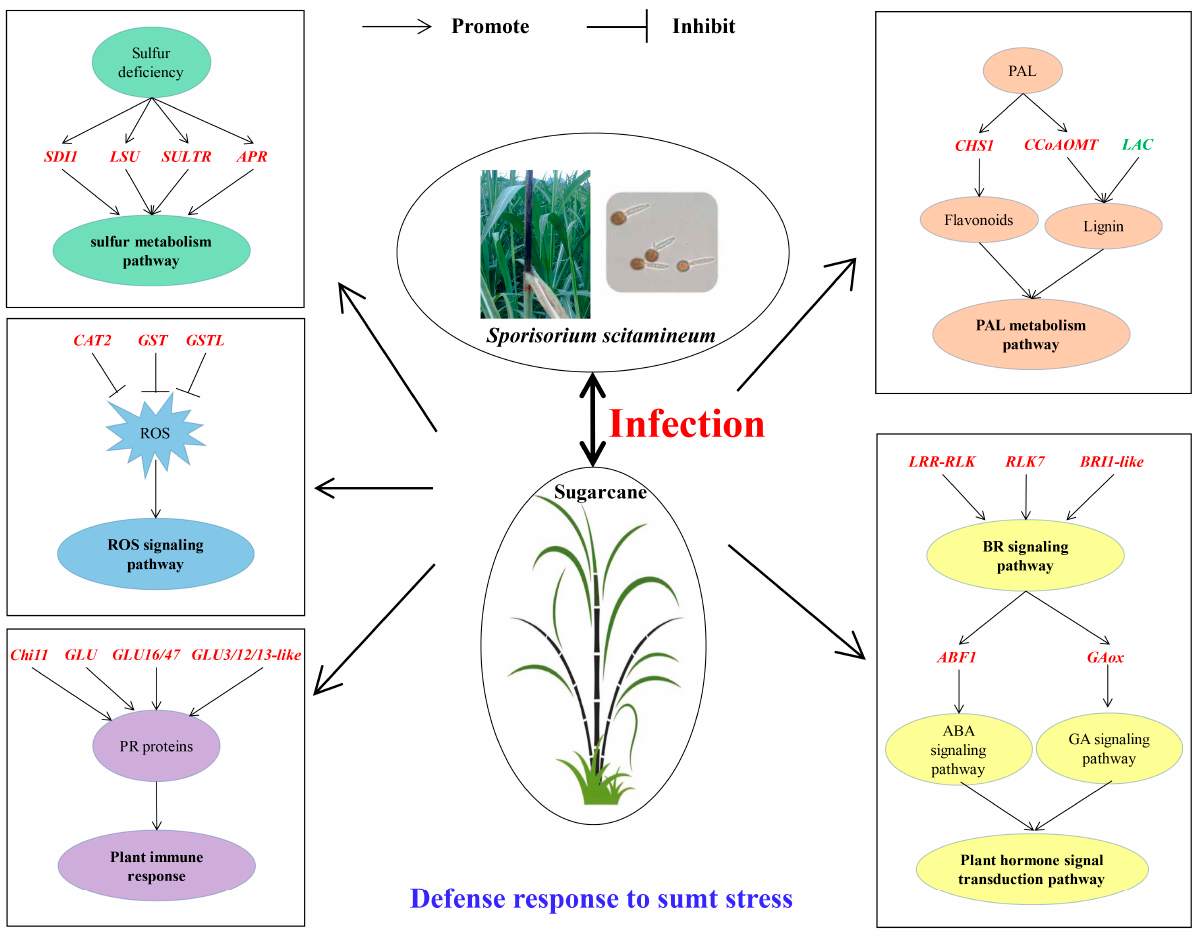
Figure 10. A model of molecular mechanism of sugarcane response to S. scitamineum infection. Positive gene regulators are written in red fonts. Negative gene regulators are written in green fonts.